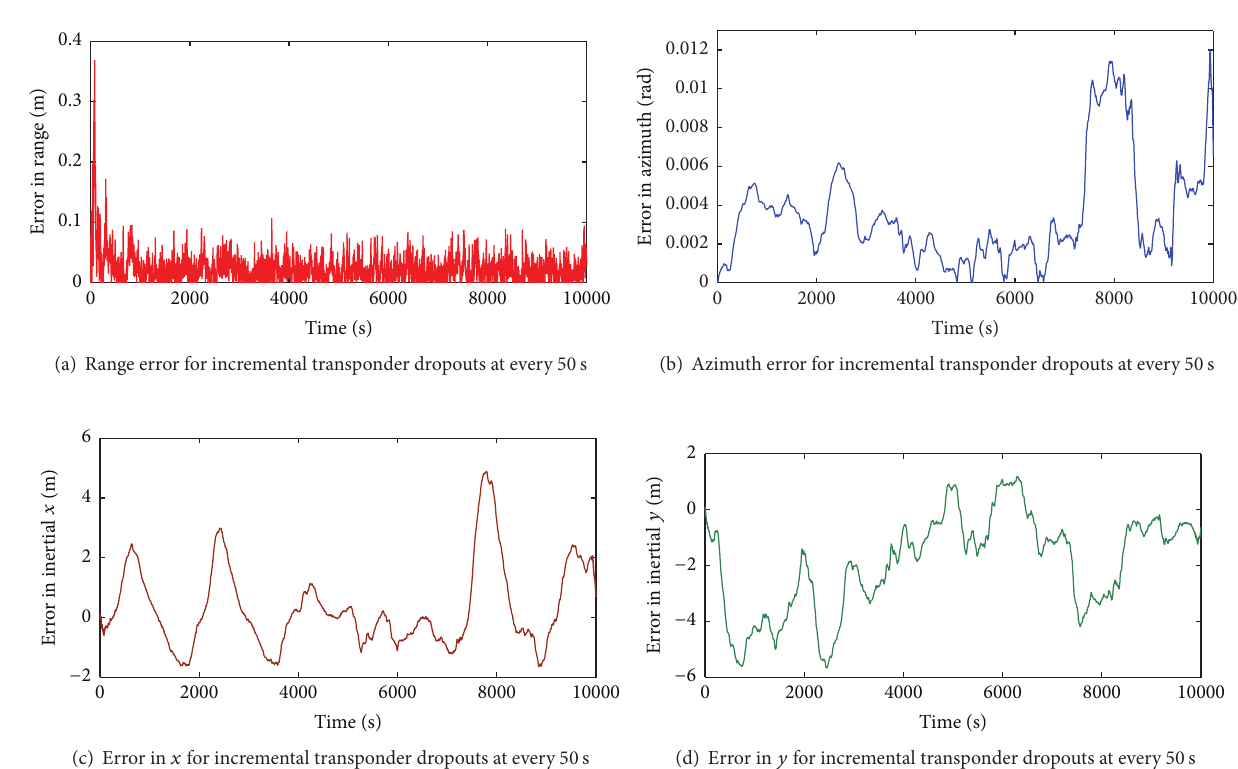
Figure 10: Navigation with incremental transponder dropouts at every 50s.